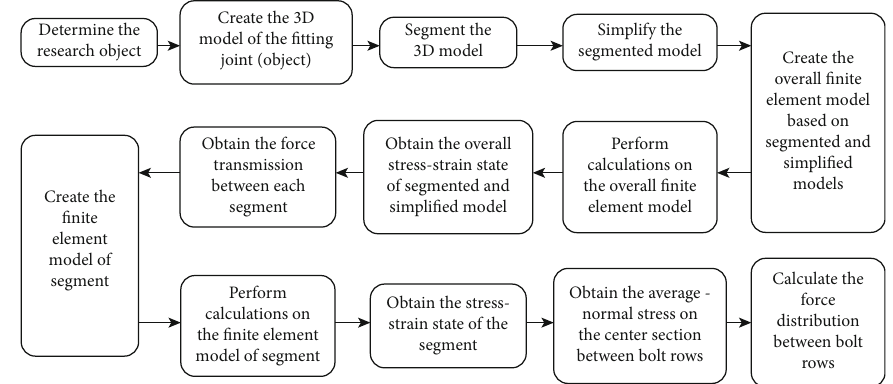
Figure 2: The execution steps for calculating the force distribution between bolt